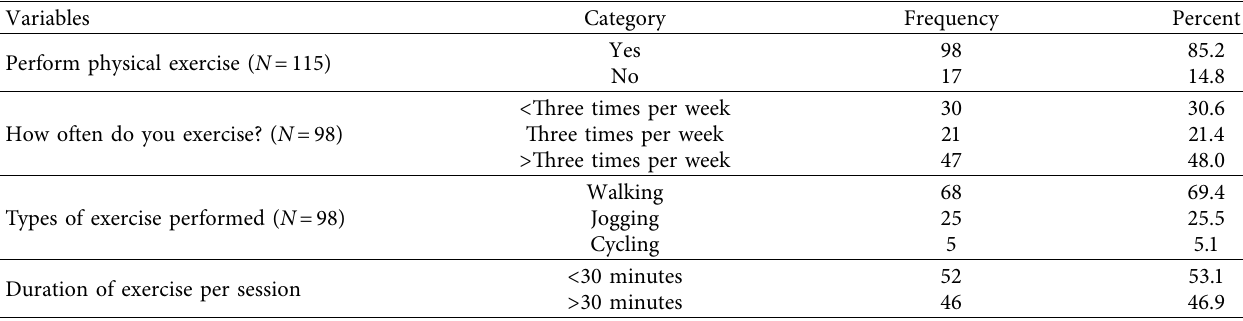
Table 4: Adherence to exercise among hypertensive patients in a follow-up clinic of Asella Referral and Teaching Hospital, Asella Town, Arsi Zone, Oromia Regional State, Ethiopia, 2020 ( n � 115). Variables